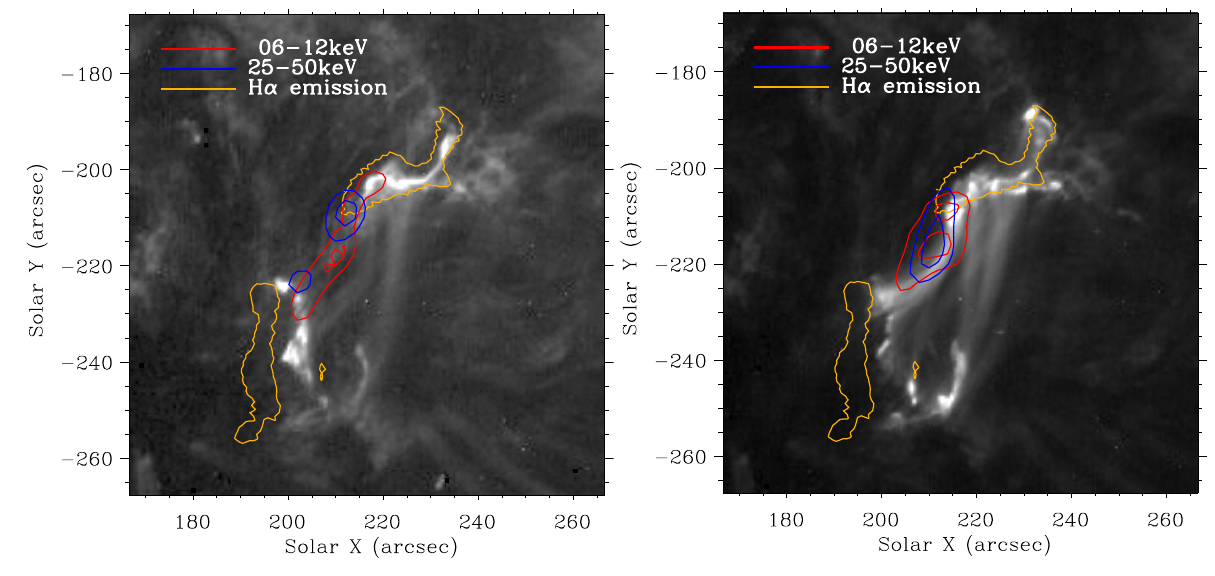
Fig. 13. UV 195 ˚A by TRACE is overlaid by HXR sources and the H α emission ribbons marked by orange contours at 09:56:47UT (left panel) and